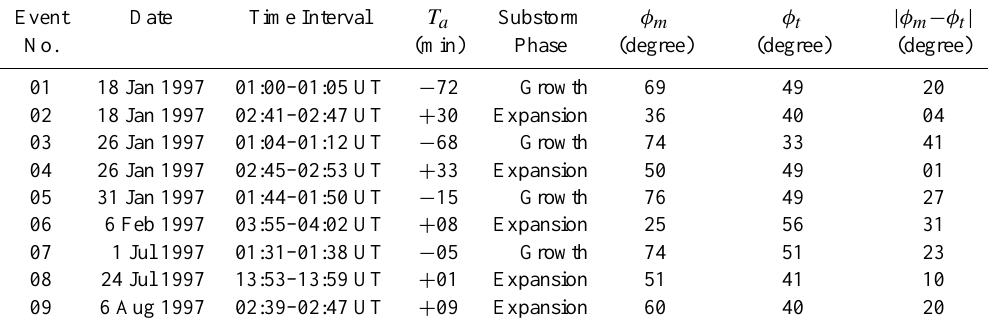
Table 1. Study events used. Event Time Interval T a